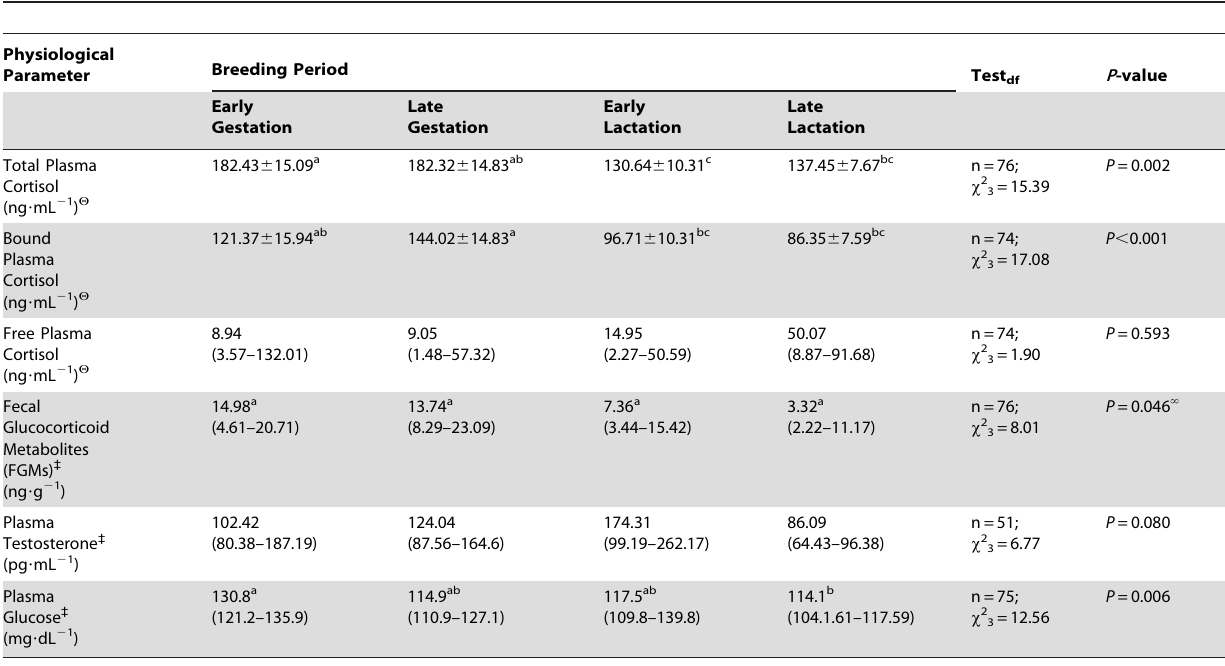
Table 1. Physiological parameters for 21 female Richardson’s ground squirrels through the breeding season.